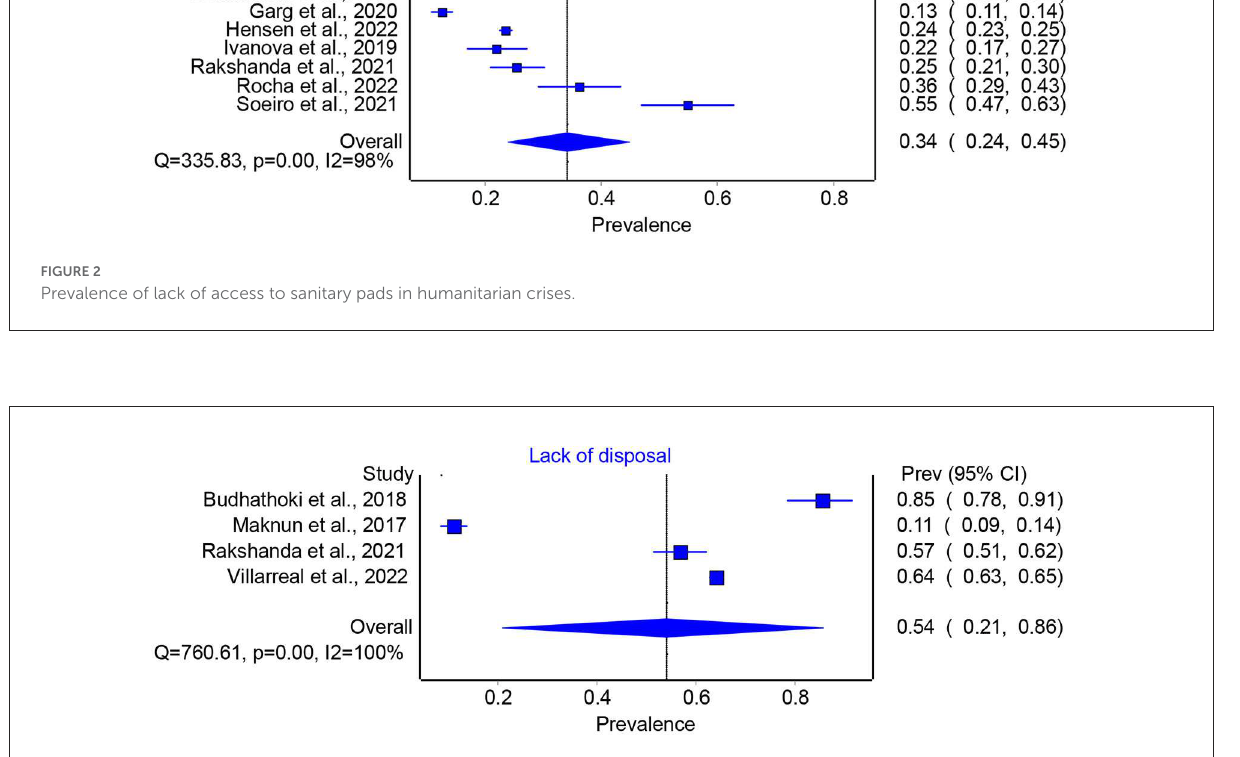
FIGURE3 Prevalence of lack of disposal facilities in humanitarian